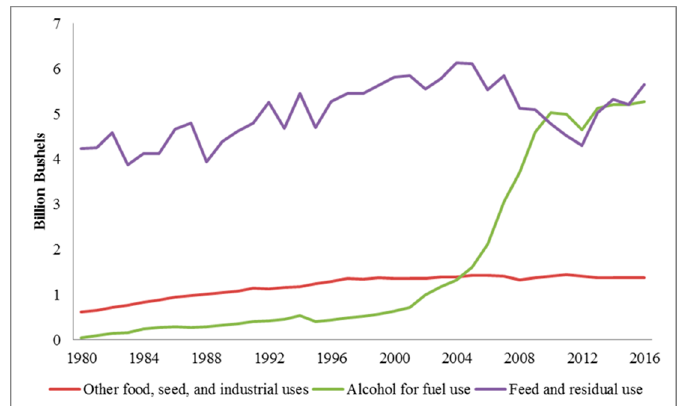
Figure 1. U.S. domestic corn use. Source: Calculated by United States Department of Agriculture (USDA) [2].